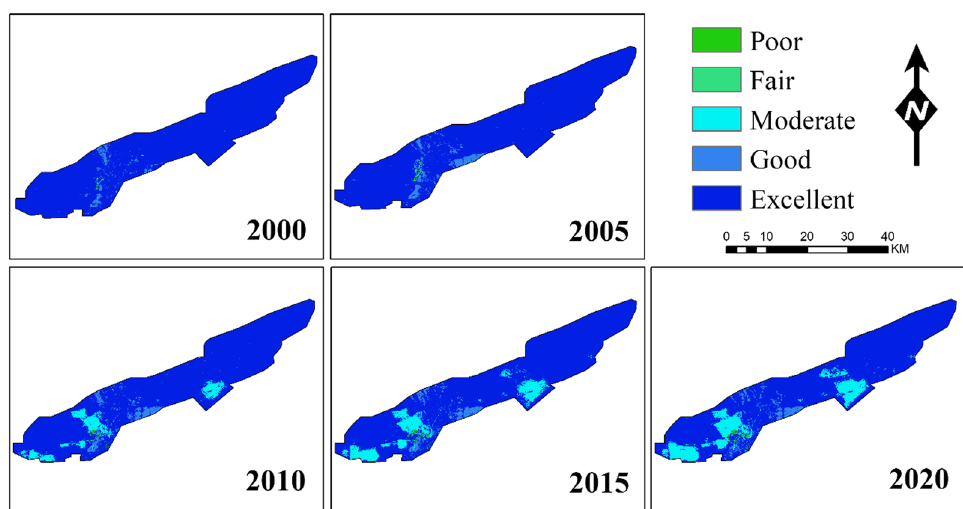
Fig. 6 Maps of ESV Classification from 2000 to 2020 Using the Natural Segment